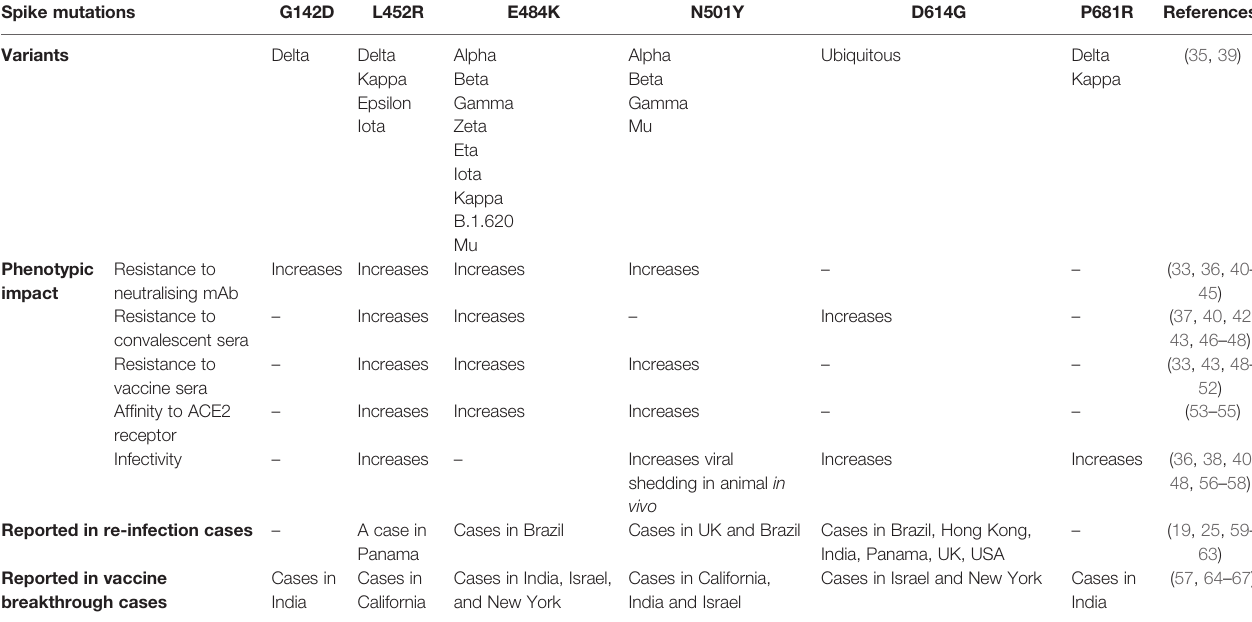
TABLE 1 | Mutations of SARS-CoV-2 spike protein, their phenotypic impact in vitro, in vivo or in silico , and reports in re-infection and vaccine breakthrough infection cases. Spike